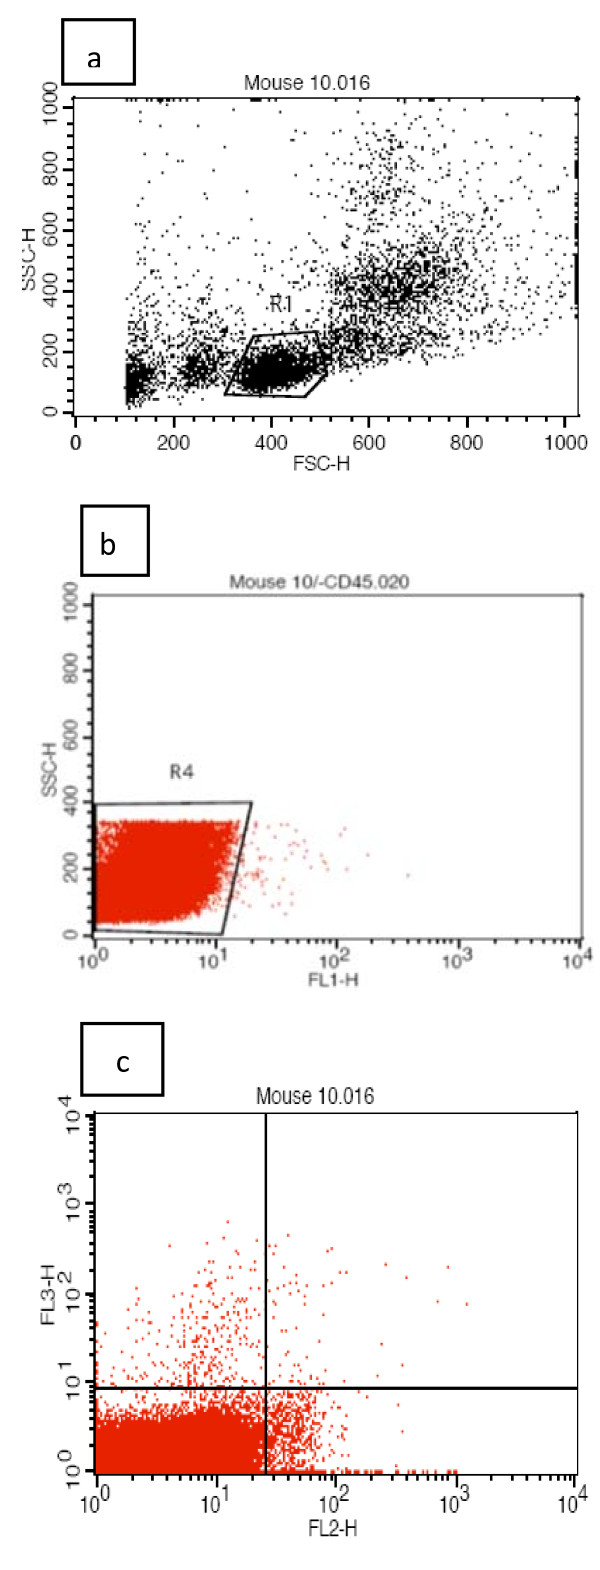
Characterization of endothelial progenitor cells (EPCs) by flowcytometry evaluation. First, cells were plotted in forward vs side scatter to gate the lymphocyte population selectively, where EPCs are usually found (a). For analysis of CD45dimCD34+KDR+ endothelial progenitor cells, CD45 was then plotted against the side scatter (b), followed by further analysis of the CD45dim population on coexpression of CD34/KDR (c).